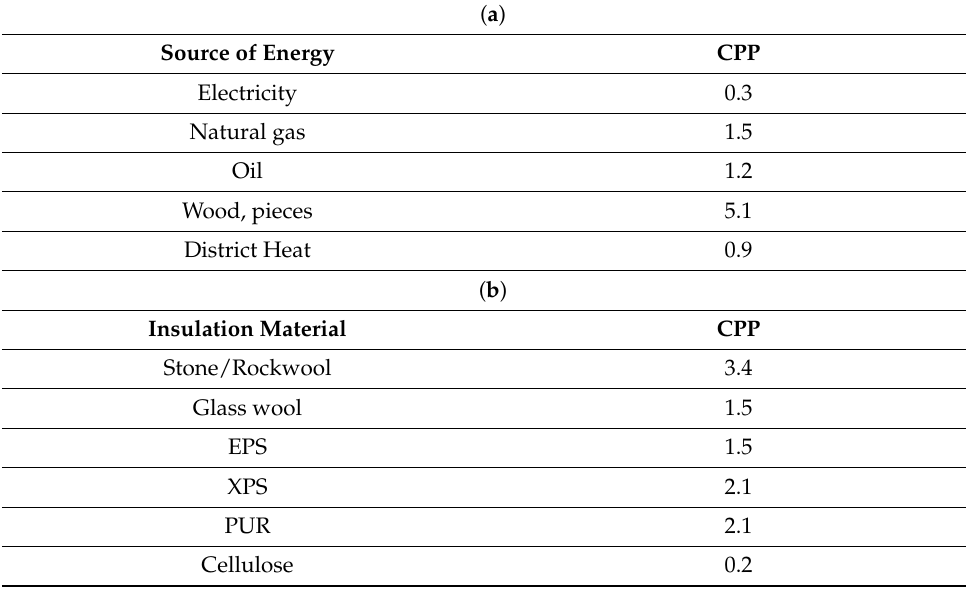
Table 7. ( a ) Average CPP values for different energy sources. ( b ) Average CPP values for various insulation